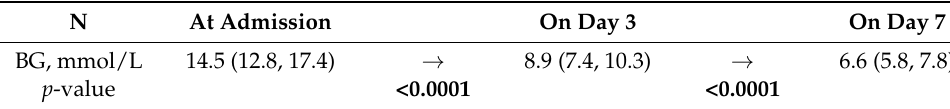
Table 3. Changes in blood glucose level (N =